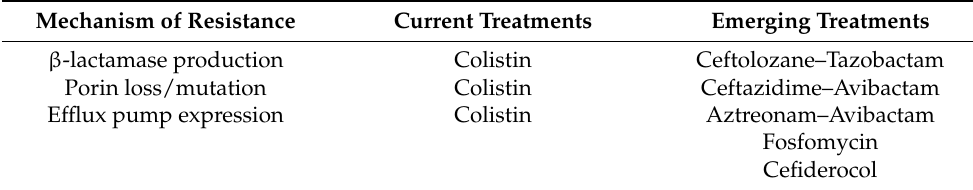
Table 1. Current and emerging treatments for P. aeruginosa